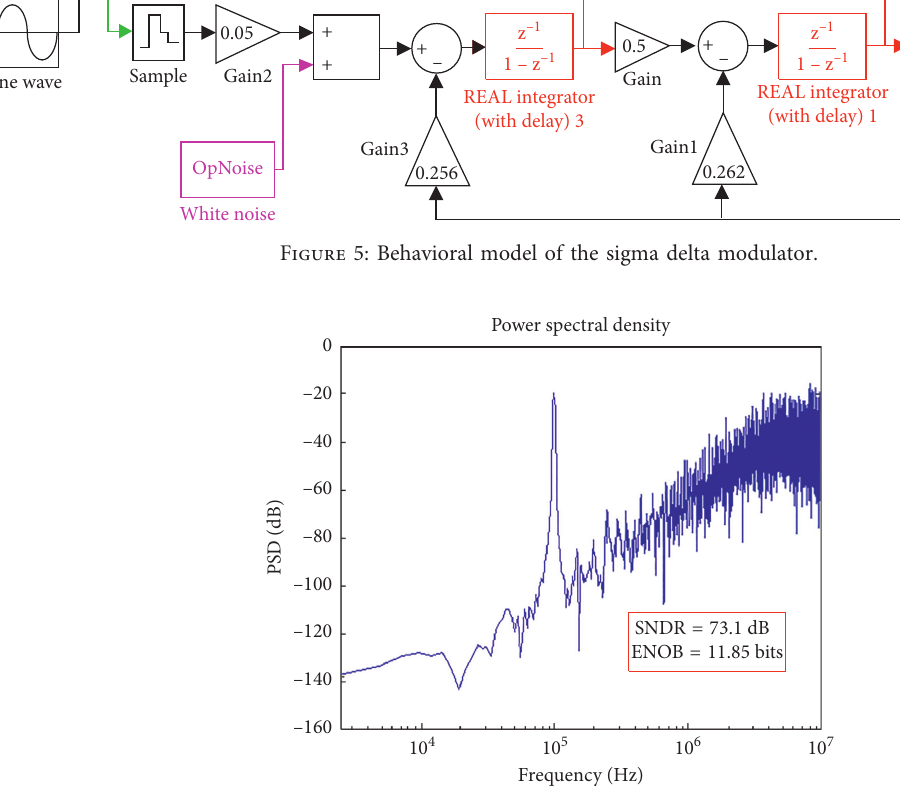
Figure 6: Output spectrum of the sigma delta modulator.